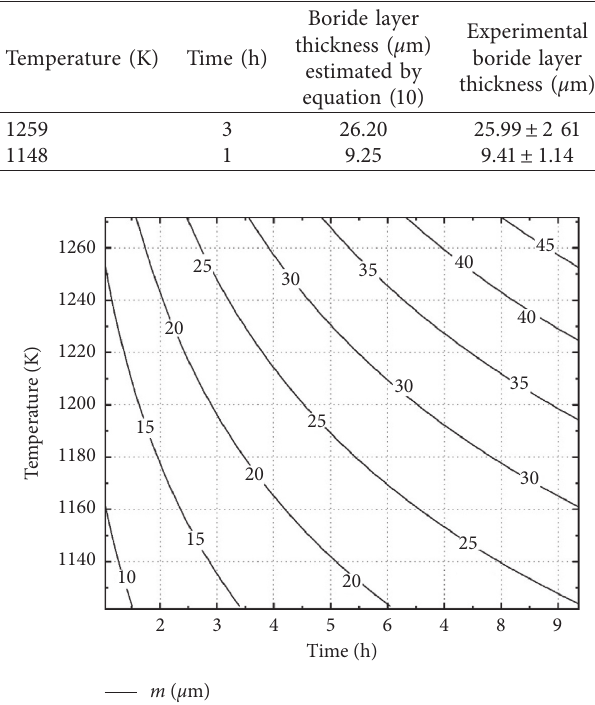
Figure 11: Contour diagram of boride layer thickness Fe of AISI W2 borided steel, as a function of temperature and